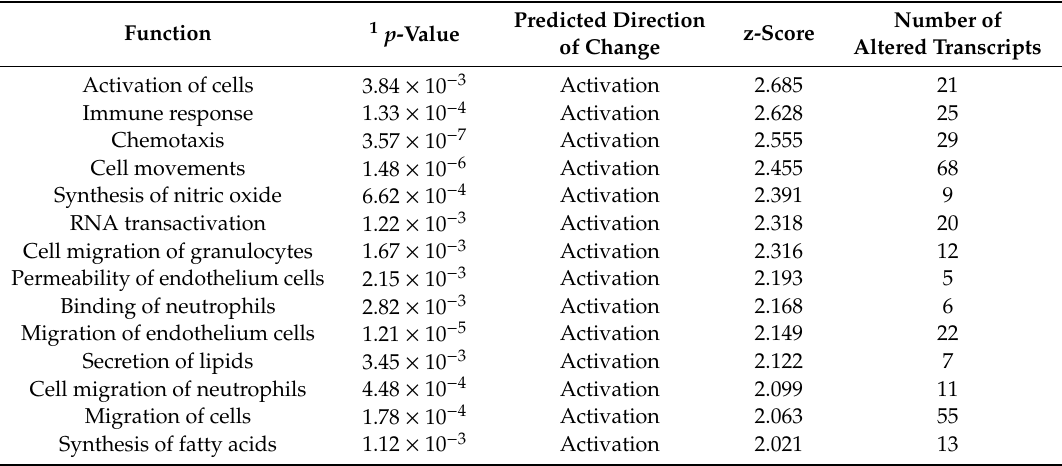
Table 1. Functions predicted to be altered in ASCs from donor 6 stimulated with 0.1 µ g / mL IM peptide, in comparison to cells cultured with FBS-deprived medium. The results were obtained with disease and function mode implemented in ingenuity pathway analysis (IPA) software. 1 p